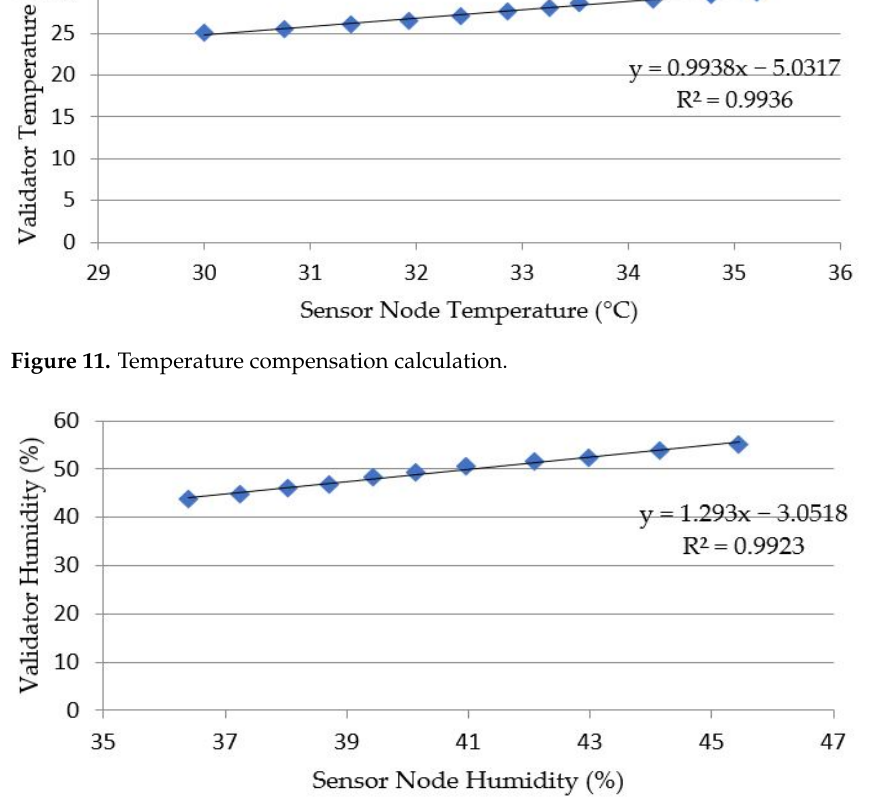
Figure 12. Relative humidity calculation. Table 11. Temperature and humidity results after